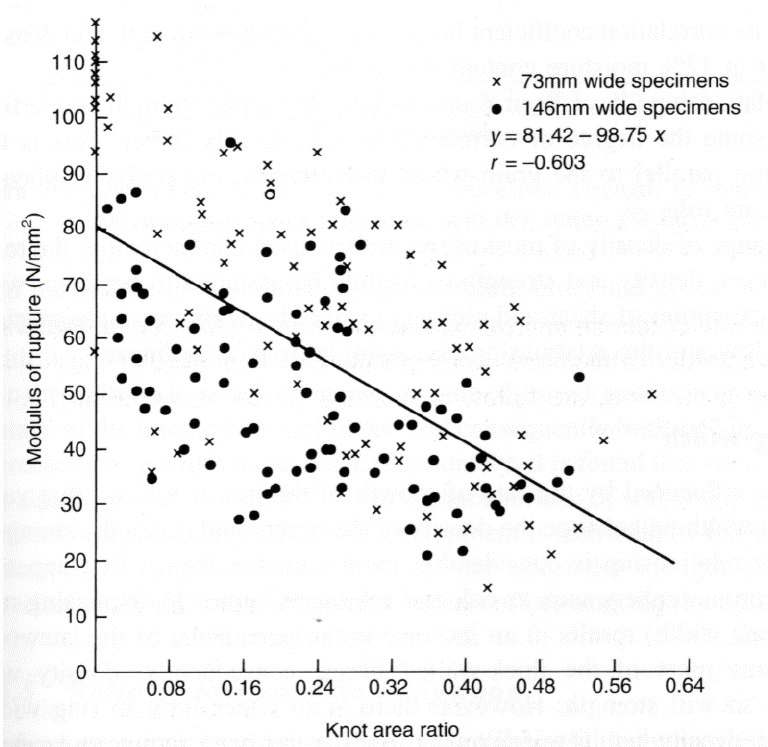
Figure 22. Effect of knot area ratio on the strength of Douglas Fir boards of two different widths. From [89]. The black circles and ‘x’ are data points.